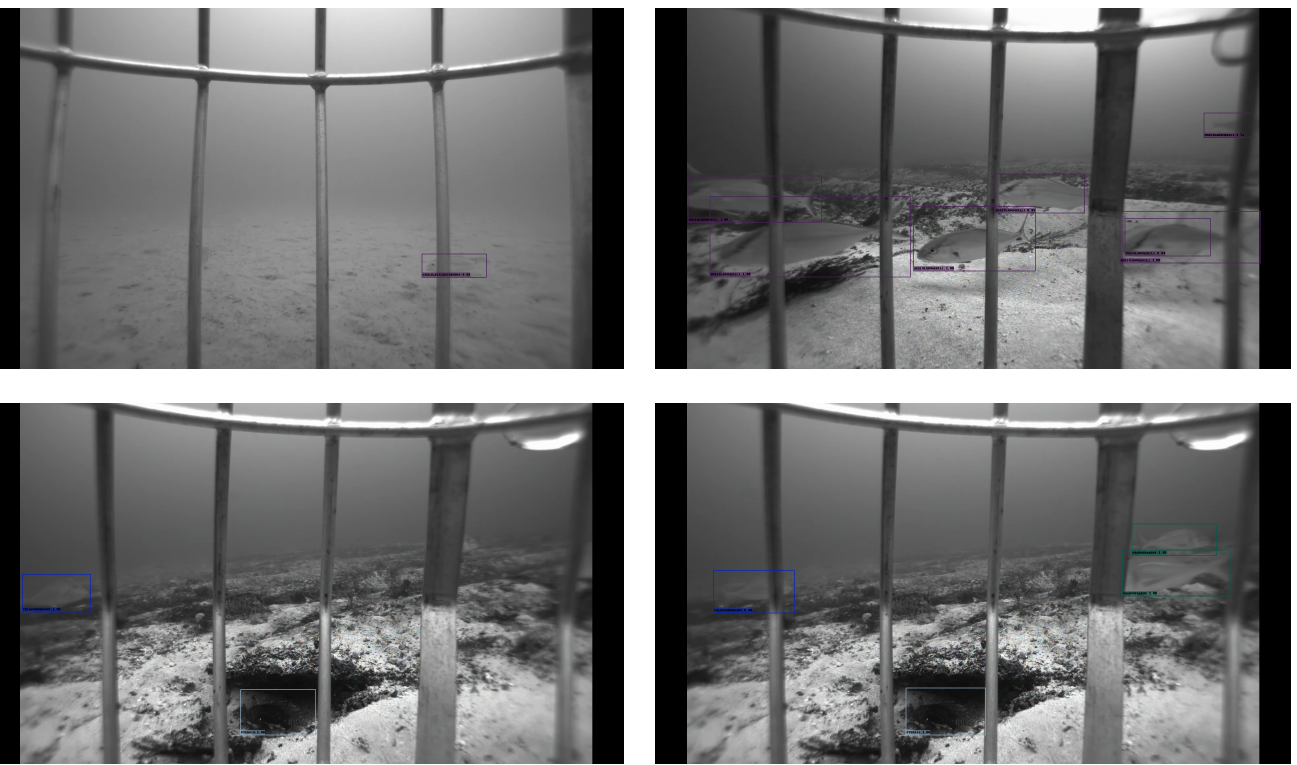
Figure 7. VGG512 backbone qualitative outputs. All fish species in each image are detected with high